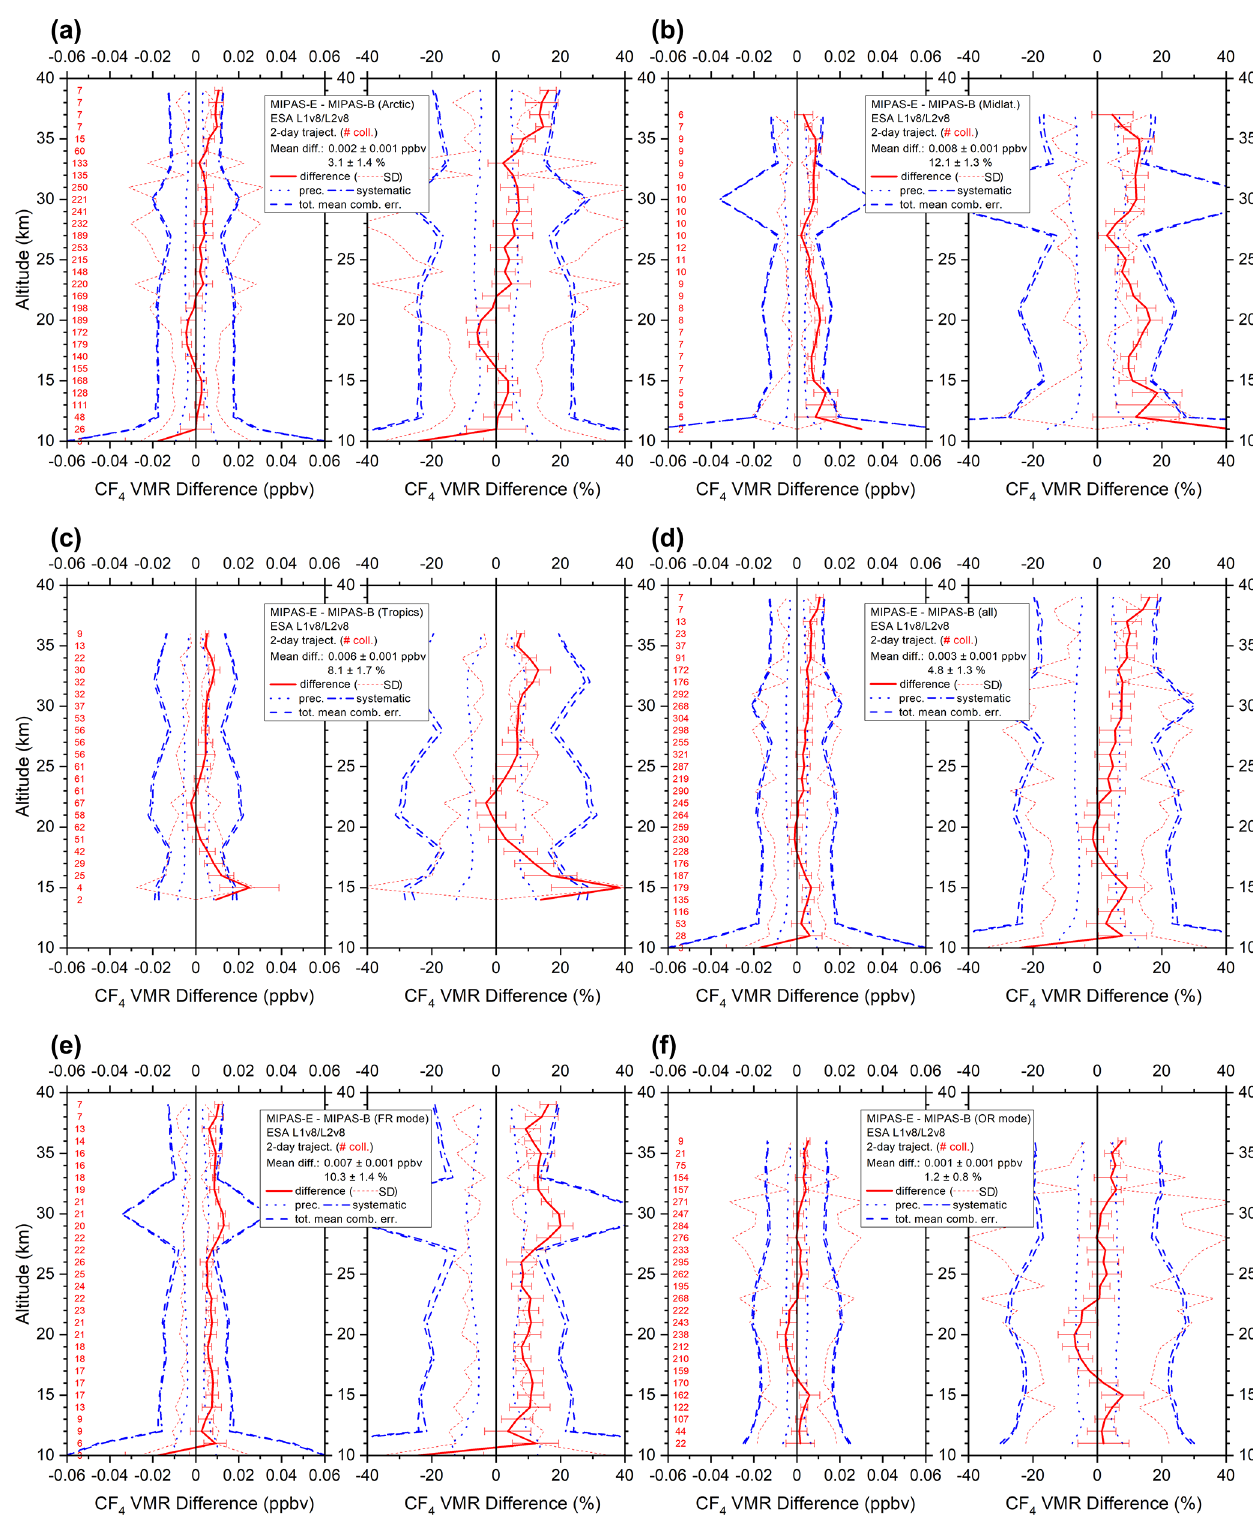
Figure 15. Same as Fig. 3 but for CF 4